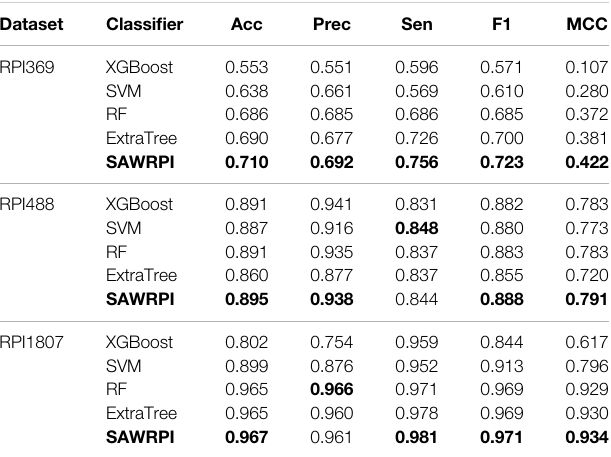
The bold values represent the higher values each column. TABLE5| Five-Foldcross-validationaverageresultsonthreedatasetsbydifferent classi fi ers. Dataset